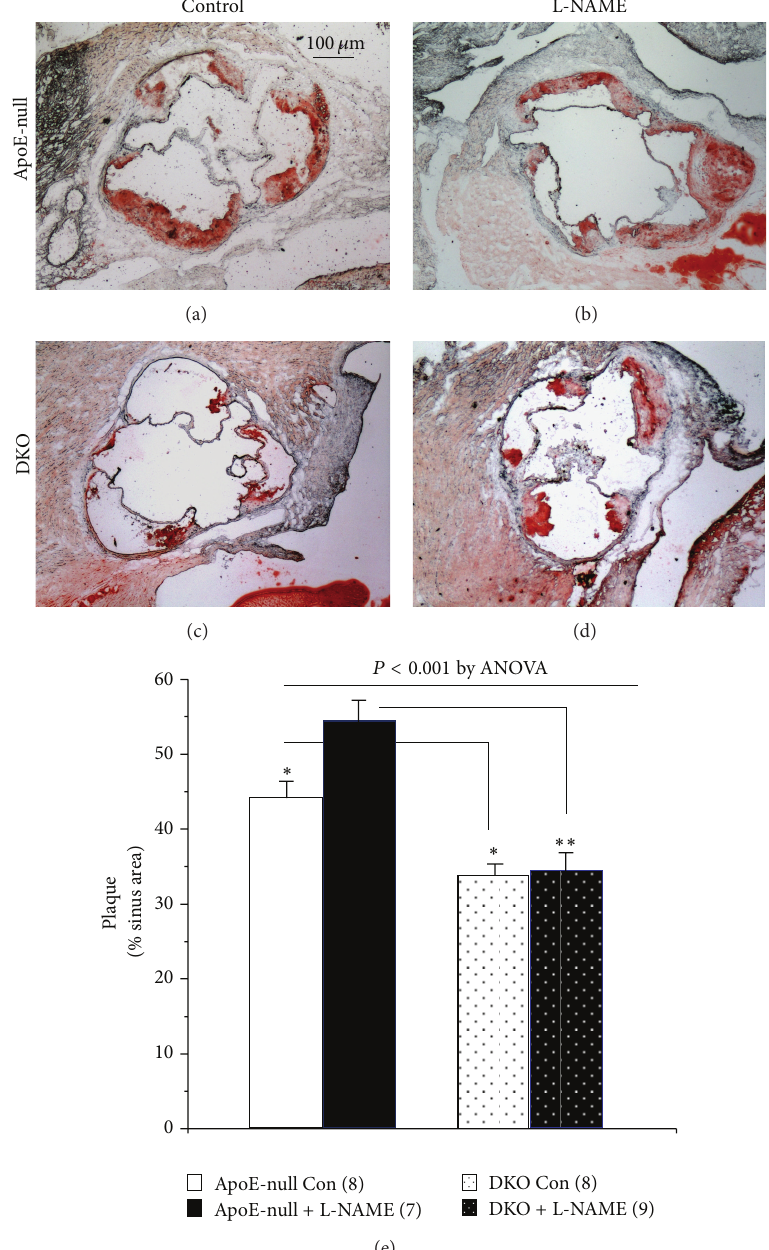
Figure 2: Atherosclerosis at the aortic sinus. Representative photographs of the oil-red-O-stained lesions ((a)–(d)), and after quantification (e), mice number in parentheses. Atherosclerosis was 23% lower in the DKO control mice (c) versus the ApoE-null (a), ∗ 𝑃 < 0.05 . L-NAME increased the extent of the plaque by 23% in the ApoE-null mice, ((a), (b), and (e)), ∗ 𝑃 < 0.05 , but had no effect in the DKO ((c), (d), and (e)), resulting in a 37% greater plaque area in the treated ApoE-null mice versus the treated DKO animals, ∗∗ 𝑃 < 0.005